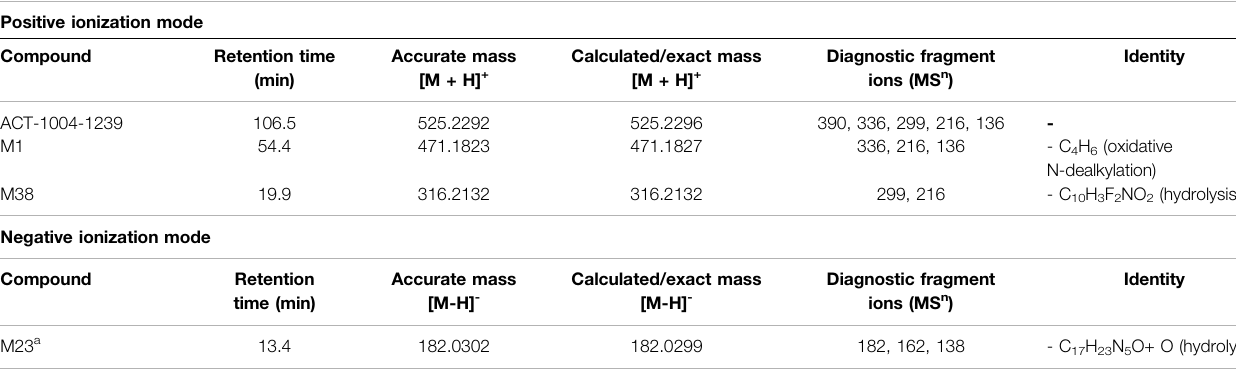
TABLE 3 | Mass spectrometric identi fi cation of 14 C-ACT-1004-1239 and its metabolites in rat